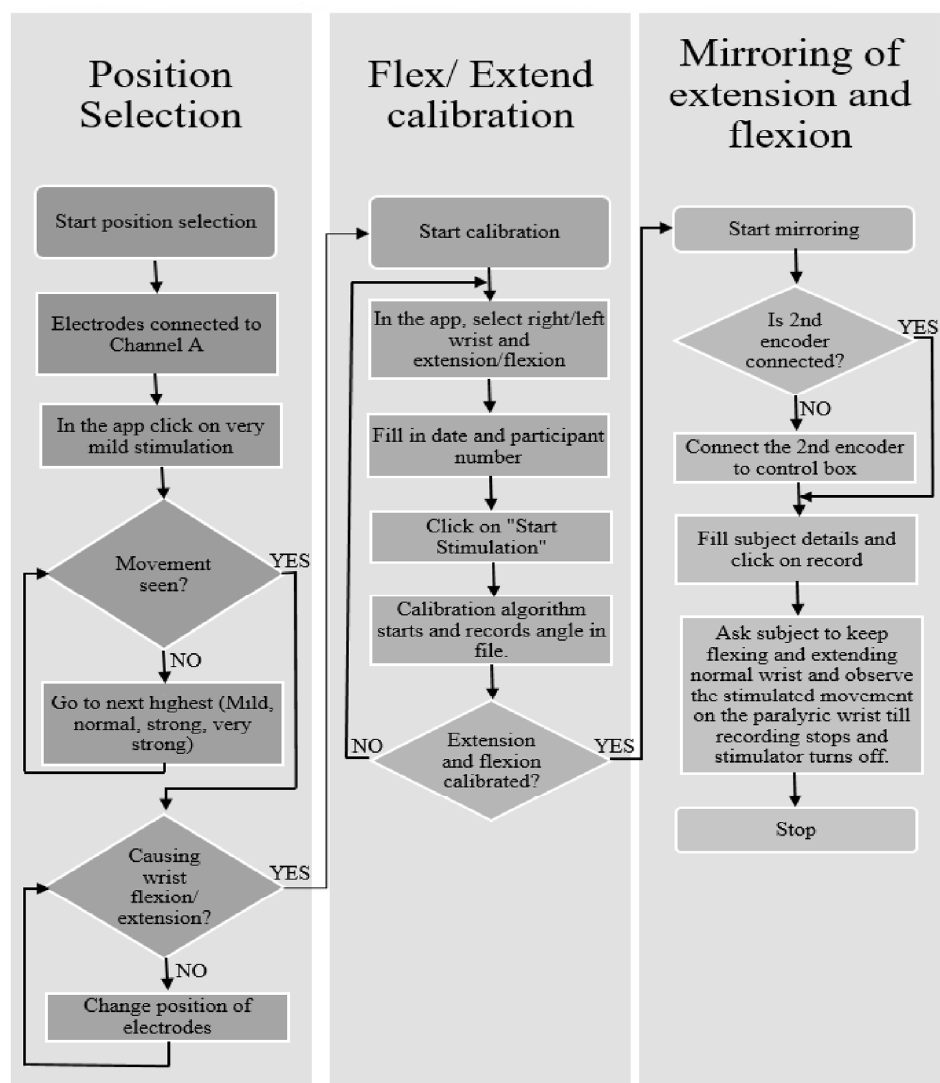
Figure 6. Algorithm to be followed for using the three apps. The Flowchart gives the details on how data were collected from each